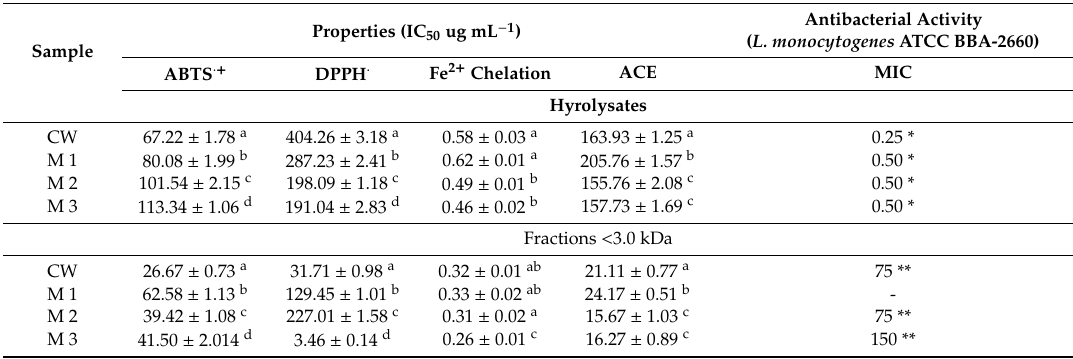
Table 3. Antioxidant, angiotensin converting enzyme (ACE) inhibitory, and antibacterial properties of hydrolysates and fractions with < 3.0 kDa